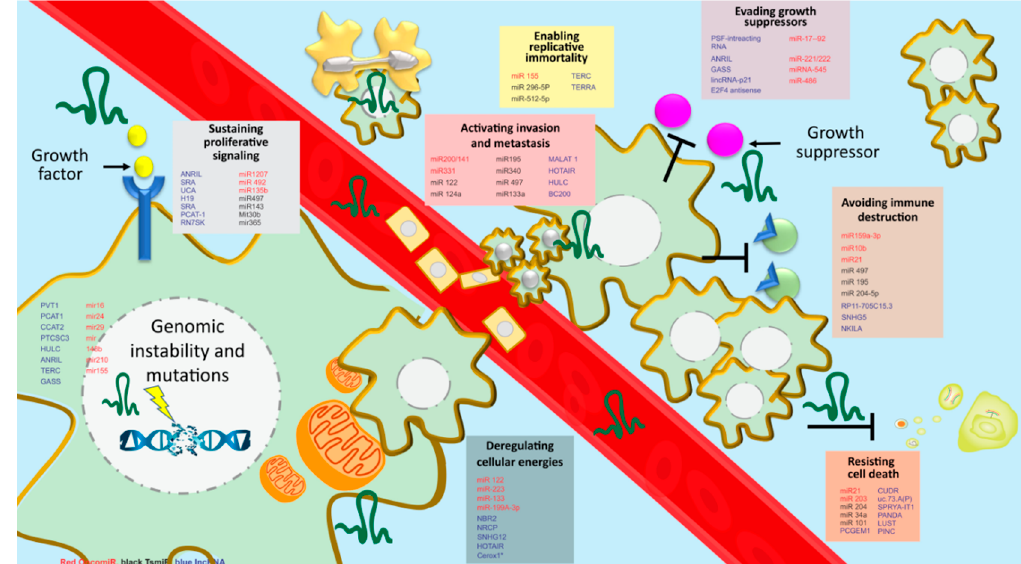
Figure 3. MicroRNA and LncRNA involved in breast cancer stemness therapy resistance and tumorigenesis. There are eight hallmarks implicated in cancer including sustaining proliferative signaling, enabling replicative immortality, evading growth suppressors, activating invasion and metastasis avoiding immune destruction, resisting cell death, deregulating cellular energetics and genomic instability and mutations. Expression of several microRNAs and lncRNA is associated with inducing oncogenic or tumor-suppressive properties via using the hallmarks of cancers.